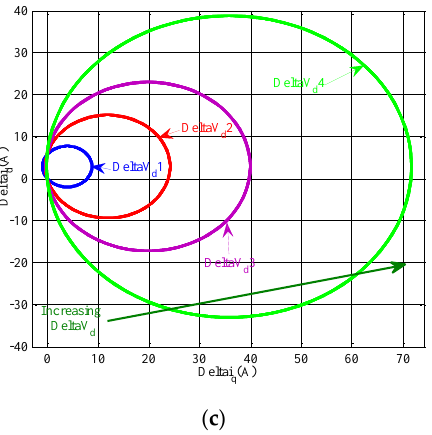
Figure 6. Effects of the variation of grid voltage magnitude error on the current error curve: ( a ) Δ v d = 0 V; ( b ) Δ v d = 10 V; ( c ) for various grid voltage magnitude errors.